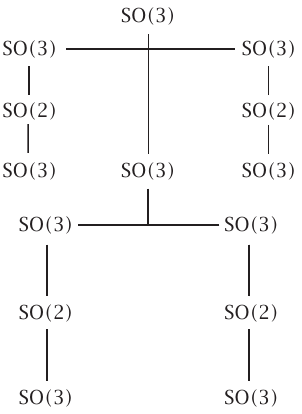
Figure 2.1 . Humanoid configuration manifold Q N modeled as